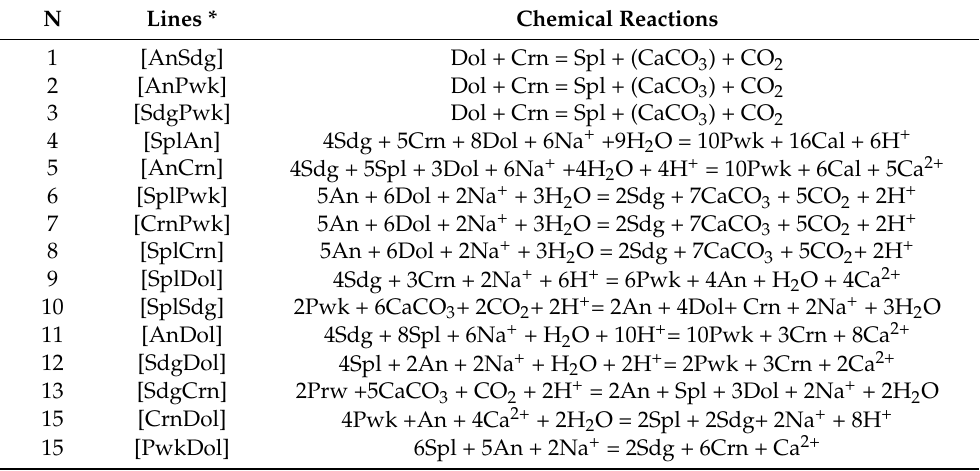
Table 6. Equations of chemical reactions occurring on lines of monovariant equilibrium. N Lines